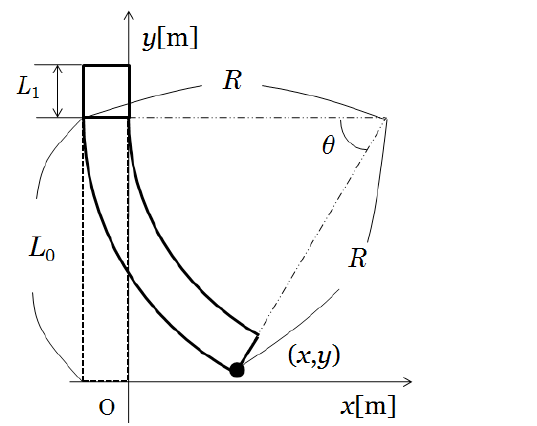
Figure 4. Simplified diagram of the actuator.